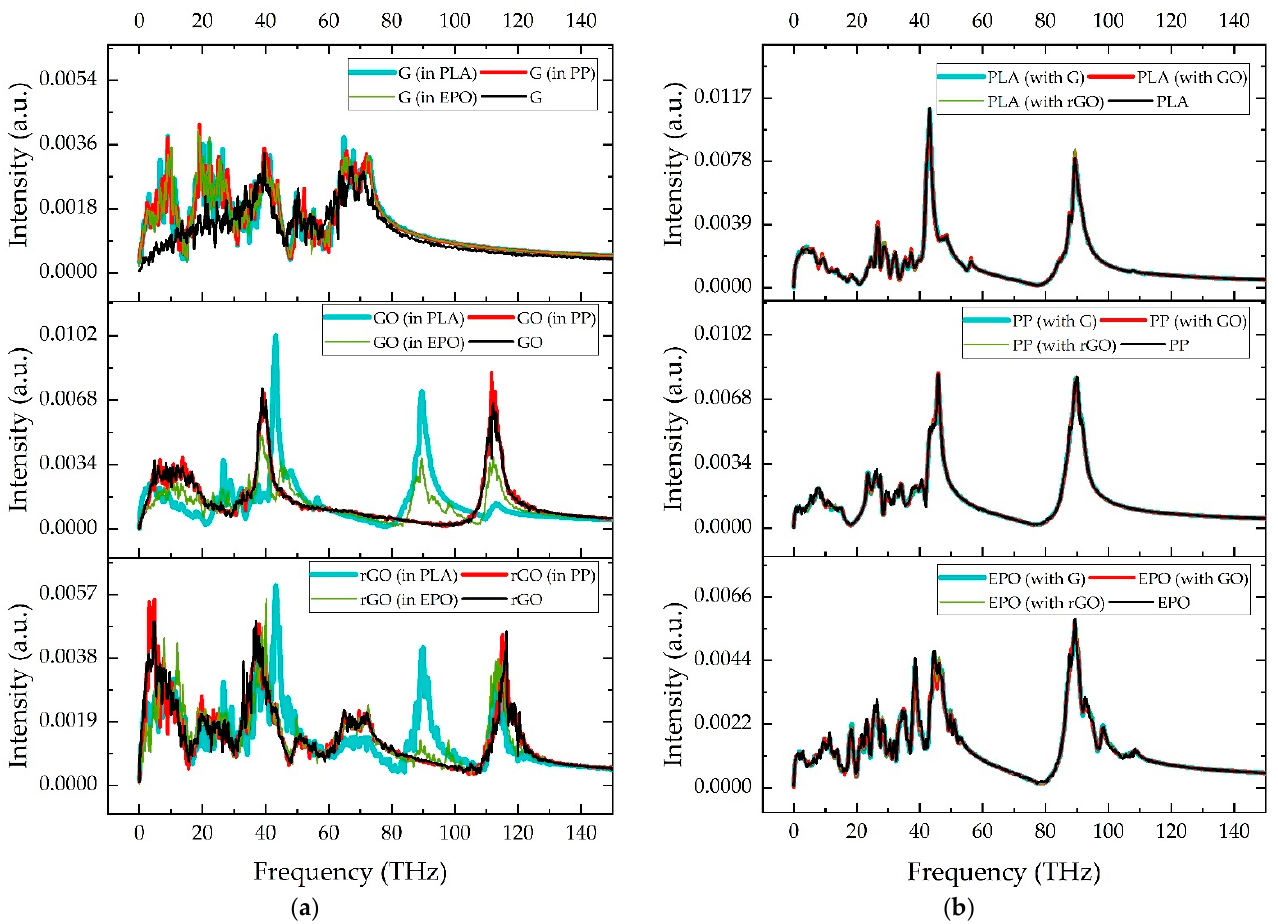
Figure 8. Phonon DOS of ( a ) graphene fillers and ( b ) polymers in composite and neat state (G: neat graphene; GO: graphene oxide; rGO: reduced graphene oxide).